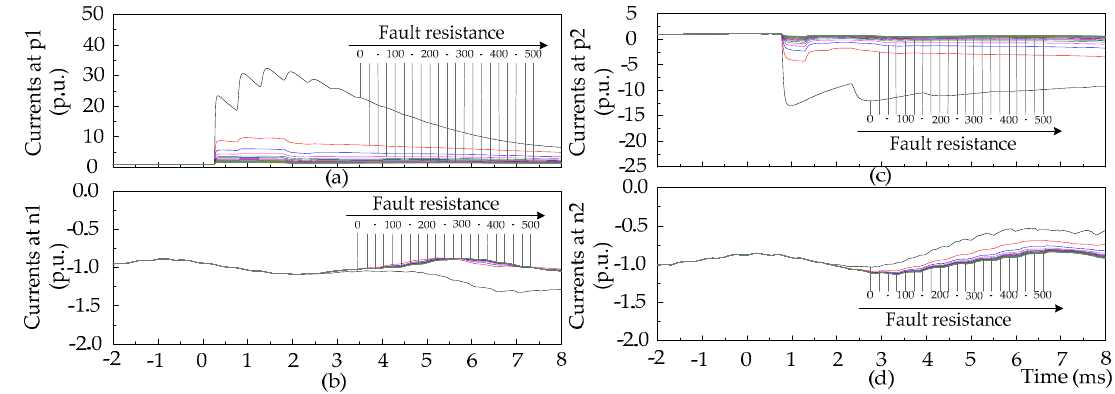
Figure 9. The DC currents of the conductor layers during PG faults 50 km from the rectifier-terminal under different fault resistance conditions. ( a ) DC currents at p1. ( b ) DC currents at n1. ( c ) DC currents at p2. ( d ) DC currents at n2.